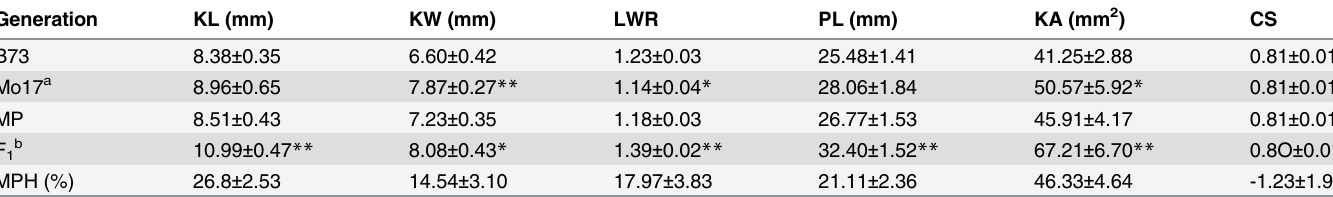
Table 1. Mean values and heterosis based on the three blocks. Generation